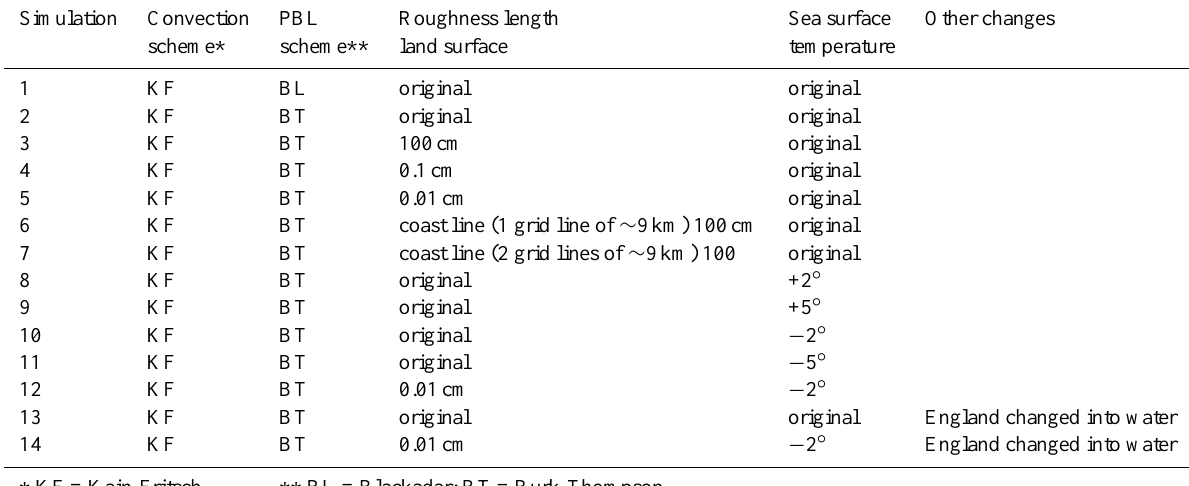
Table 1. Summary of the numerical experiments, carried out in order to determine the best combination of parameterizations (simulation 1 and 2), the comparison with operational models (simulation 2) and the sensitivity analyses on land and sea surface conditions on coastal front